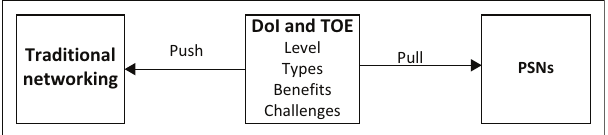
FIGURE 1: Author’s simplified theoretical framework.